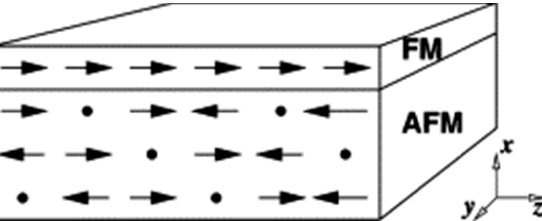
Figure 3. Exchange bias model used in the domain state model, consisting of one ferromagnetic and three diluted antiferromagnetic layers. Reprinted with permission from [48], Copyright 2001 Elsevier.